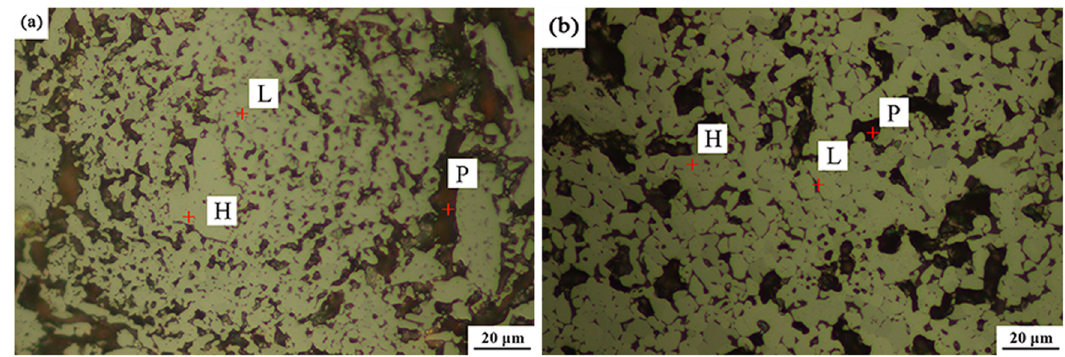
Figure 3: Micrographs of Australian ore with varying ( K 2 O + Na 2 O ) : ( a ) 0 wt% and ( b ) 0.6 wt% ( H - Hematite, L - Slag, P - Viods ) .